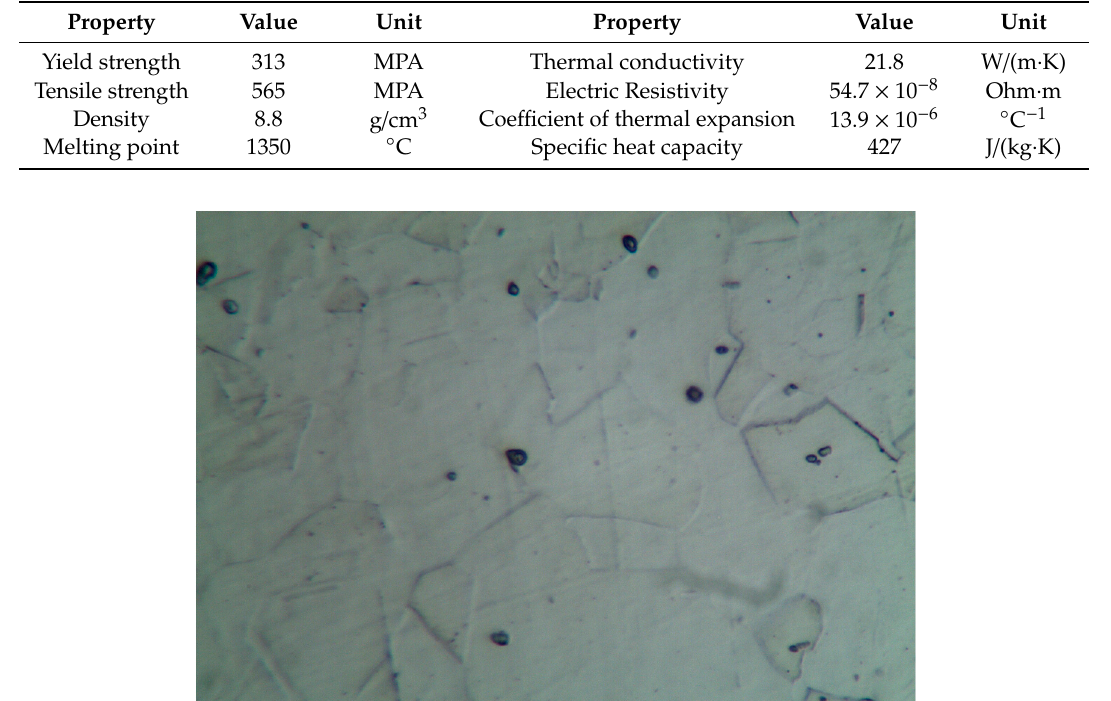
Table 2. Monel 400 mechanical properties.